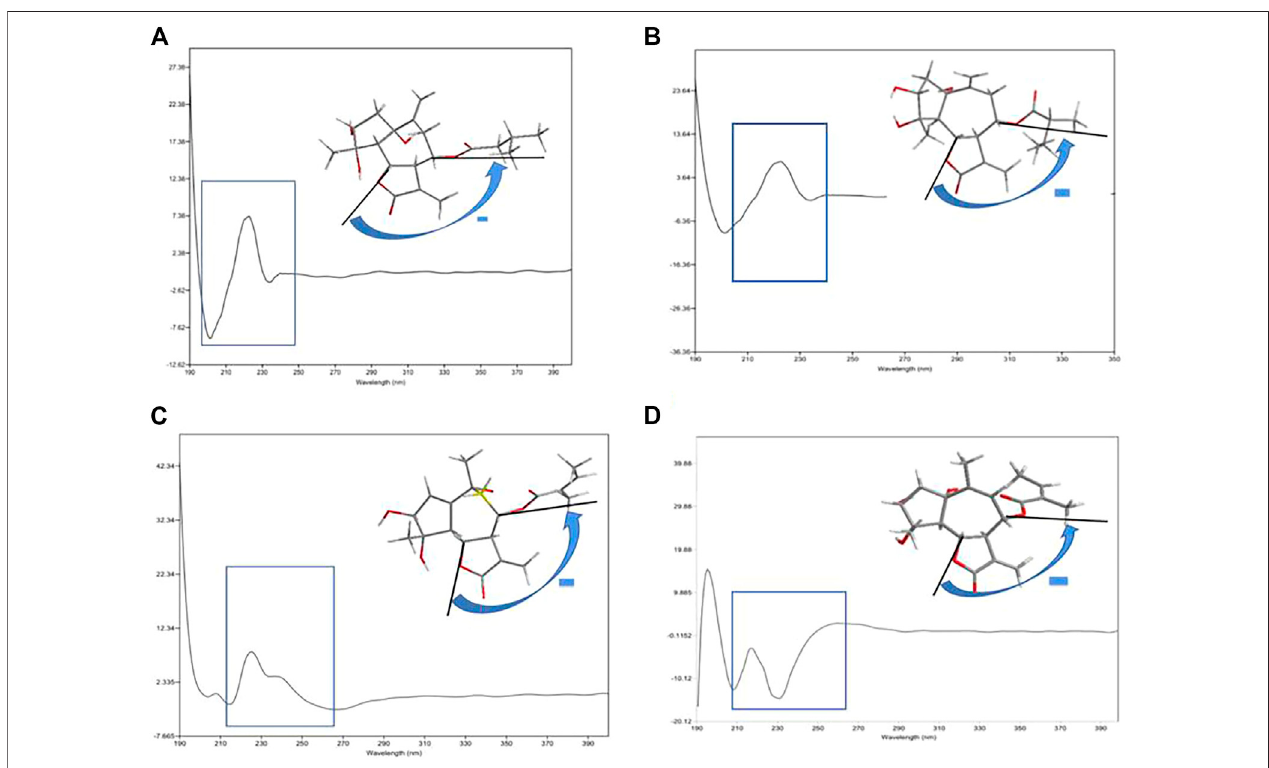
FIGURE 4 | ECD exciton chirality of compounds 1 (A) , 2 (B) , 3 (C) , and 4 (D) .